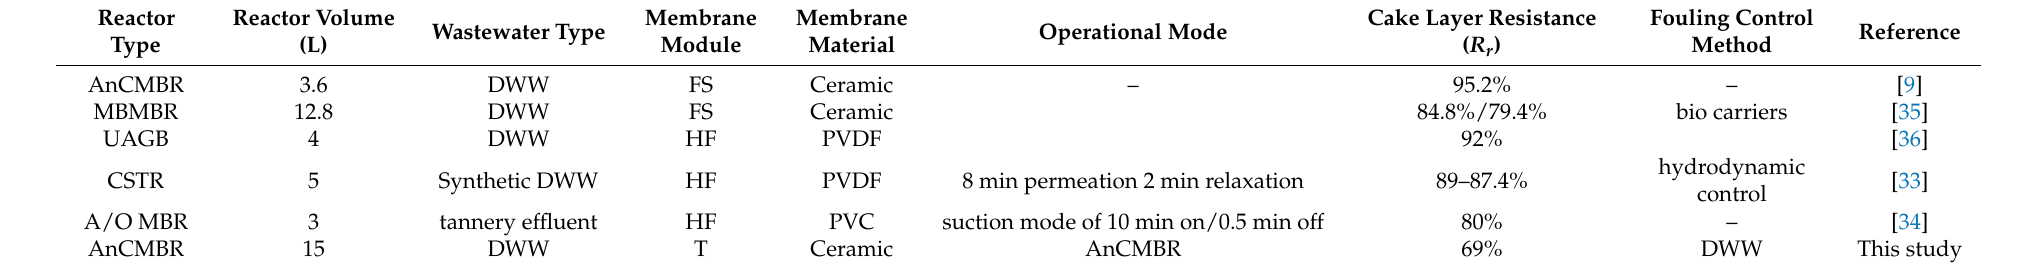
Table 2. The comparison of the cake layer resistance at different membrane bioreactor (MBR)